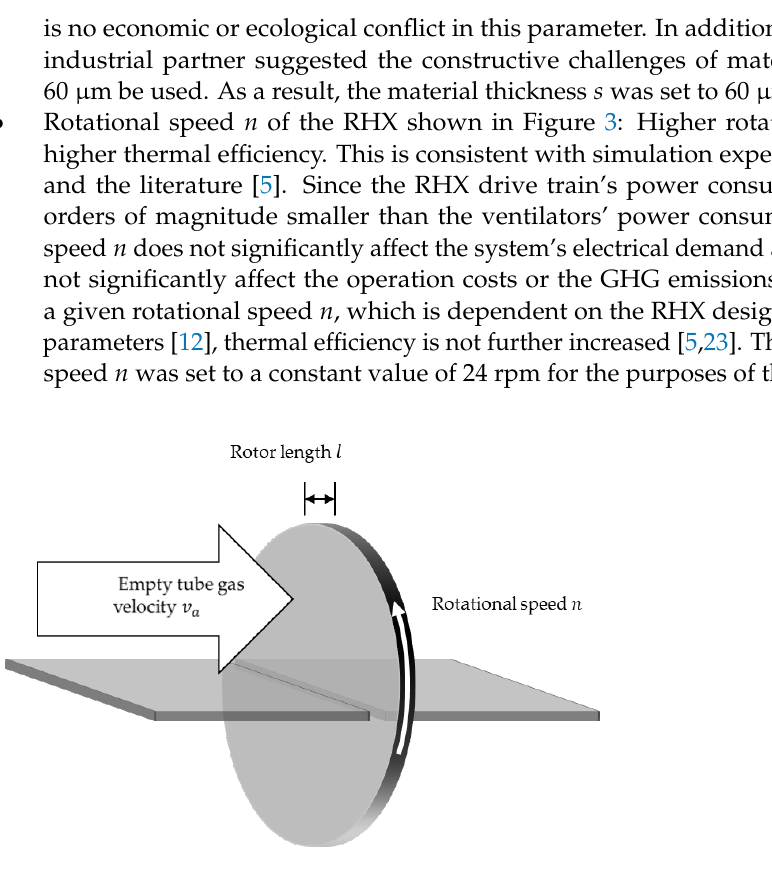
Figure 3. RHX length 𝑙 and operational parameters.